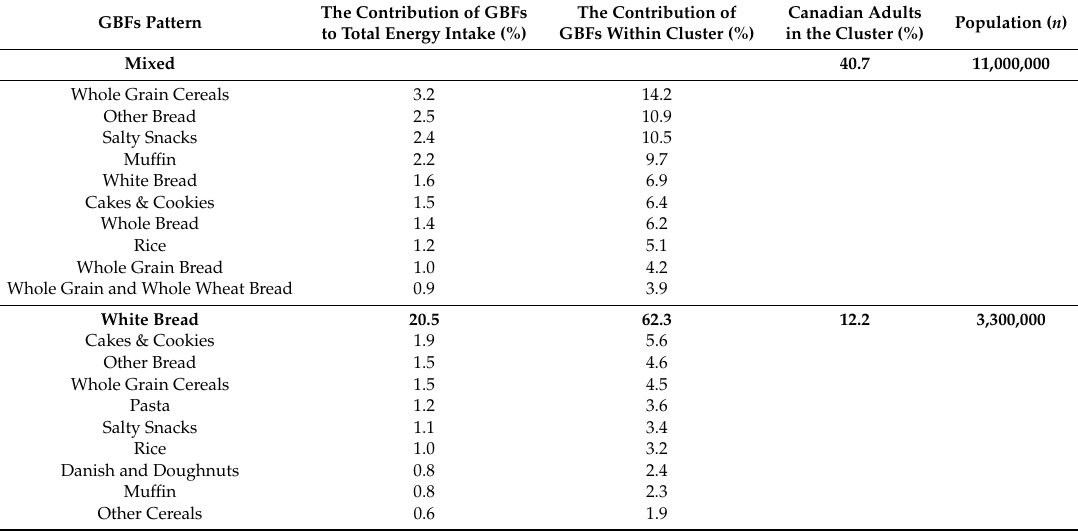
Table 1. Grain consumption patterns among adults (Canadian Community Health Survey 2015). The Contribution of GBFs The Contribution of GBFs Pattern to Total Energy Intake (%) GBFs Within Cluster